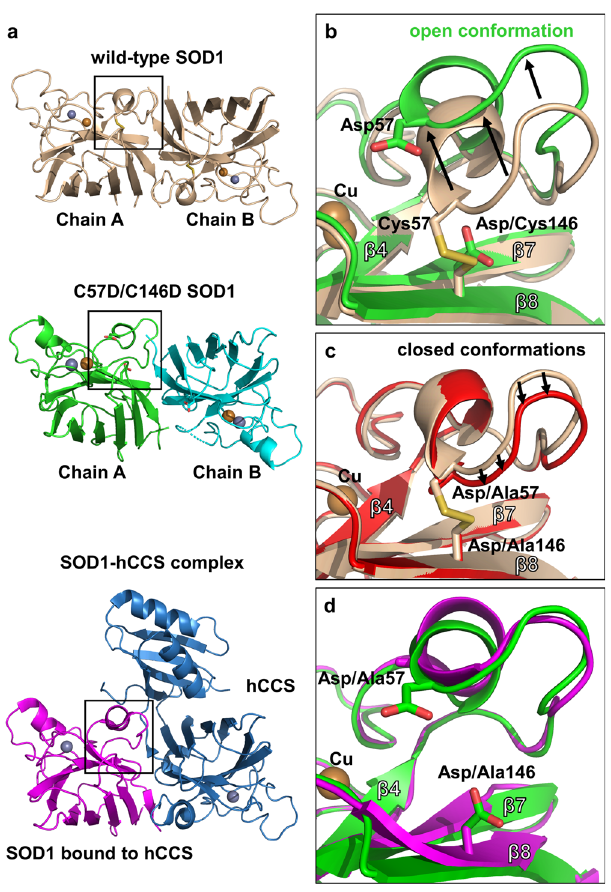
Fig. 3 Crystal structure of the C57D/C146D mutant SOD1 at 1.8 Å resolution. a Structural comparison of C57D/C146D mutant SOD1 (chain A;green, chain B; cyan) with wild-type holo-SOD1 dimer (wheat) or with C57A/C146A mutant SOD1 (magenta) bound to human copper chaperone of SOD1 (hCCS, blue) (6FP6). The structure of the asymmetric unit of C57D/C146D mutant SOD1 consists of two protomers (chains A and B). Each subunit is depicted by the ribbon representation. The gold spheres represent Cu 2 + , and the gray spheres represent Zn 2 + . The loop IV regions are marked as three small boxes. b Loop IV region in the C57D/C146D mutant SOD1 structure aligned with wild-type SOD1. The C57D/C146D mutant SOD1 is colored green, and the wild-type SOD1 structure is colored wheat. The secondary structural elements are labeled. The gold sphere represents Cu 2 + . Each residue is labeled and indicated in the stick representations with the ribbon diagram of the background. c Loop IV region in the C57A/C146A mutant SOD1 structure (6FOI) aligned with wild-type SOD1. The C57A/C146A mutant SOD1 is colored red, and the wild-type SOD1 structure is colored wheat. The secondary structure elements are labeled. The gold sphere represents Cu 2 + . Each residue is labeled and indicated in the stick representations with the ribbon diagram of the background. d Loop IV region of the C57D/C146D mutant SOD1 structure aligned with the C57A/C146A mutant SOD1 structure bound to the hCCS (6FP6). The C57D/C146D mutant SOD1 is colored green, and the C57A/C146A mutant SOD1 is colored magenta. The secondary structural elements are labeled. The gold sphere represents Cu 2 + . Each residue is labeled and indicated in the stick representations with the ribbon diagram of the